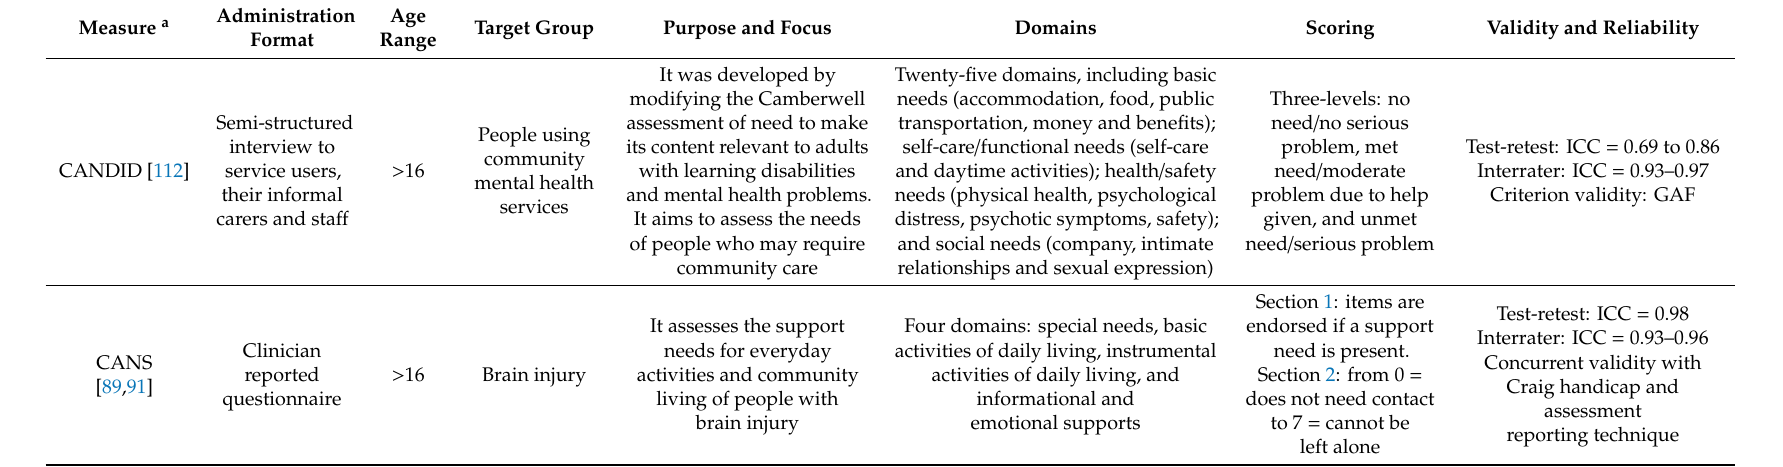
Table 2. Measurement Tools of Support